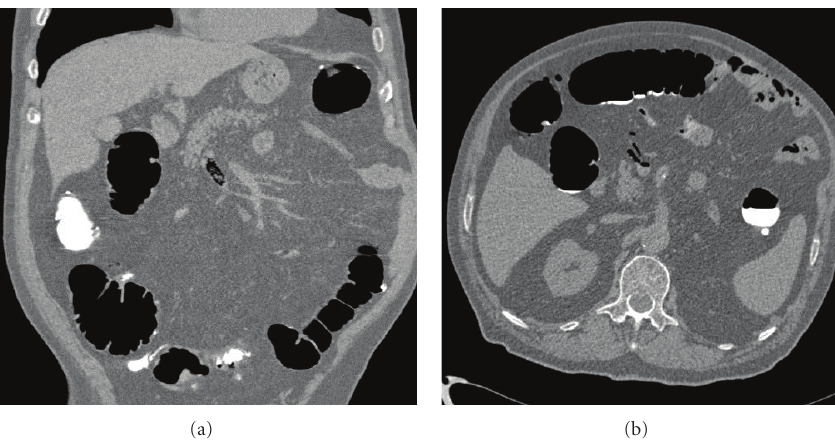
Figure 1: (a) Coronal contrast enhanced CT of the abdomen demonstrated the presence of gas in mesenteric vein and in the portal venous system. (b) Axial contrast enhanced CT of the abdomen demonstrated the presence of gas in mesenteric vein and in the portal venous system.